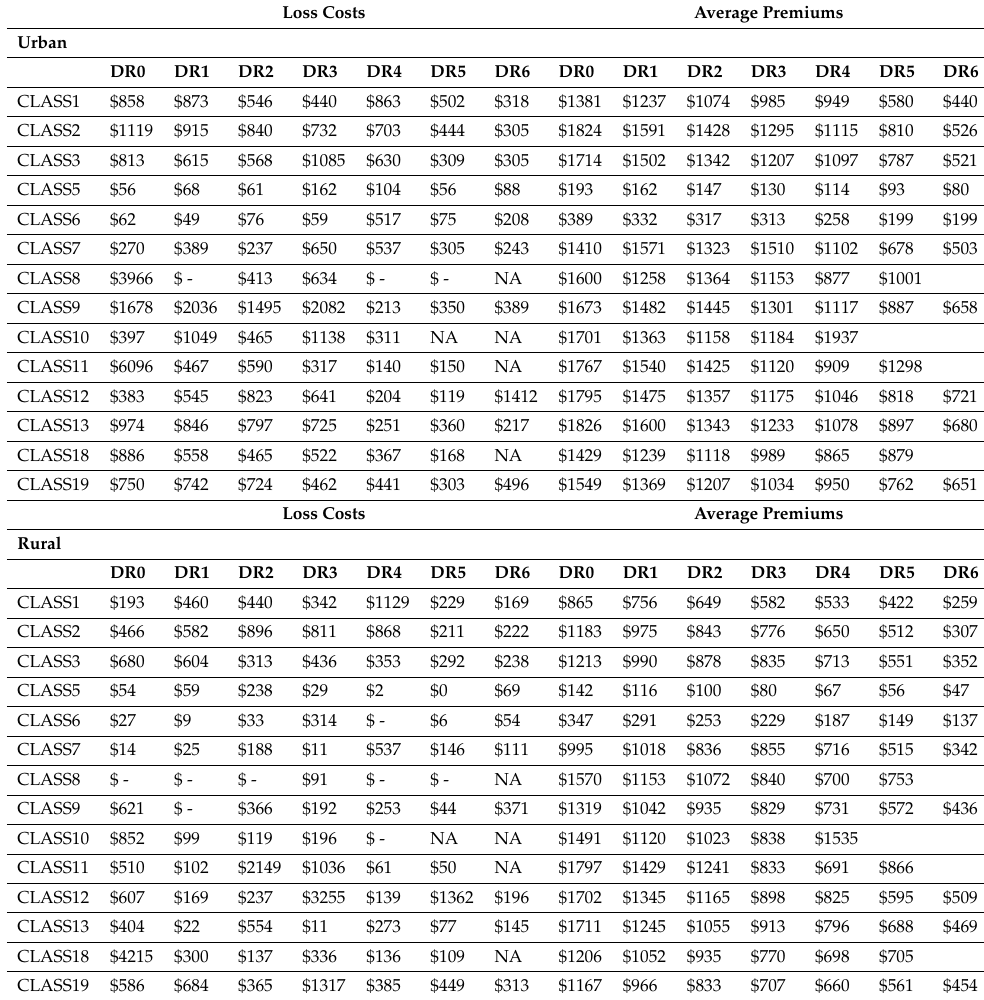
Table 1. The comparison of loss costs and premiums (in Canadian dollars), separated by territory for the accident year 2011 and AB coverage, calculated based on a pool of total 4.5 millions risk exposures (i.e., vehicle